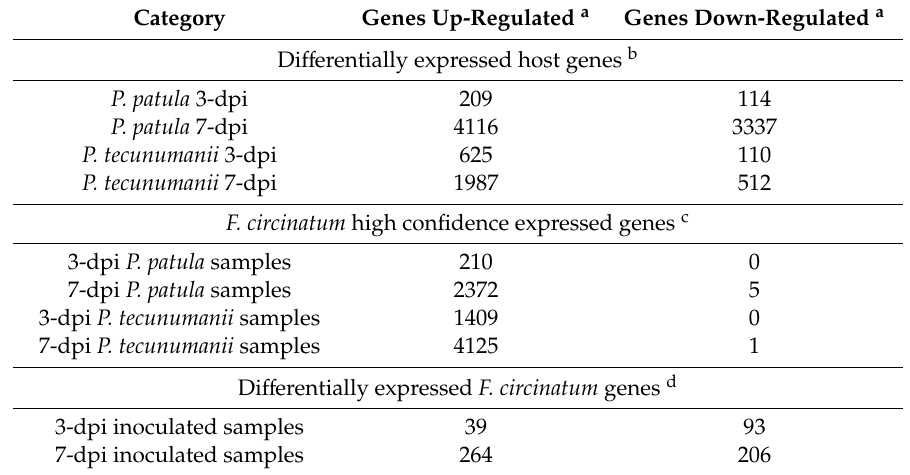
Table 1. Summary of significant di ff erentially expressed genes identified for each comparison.